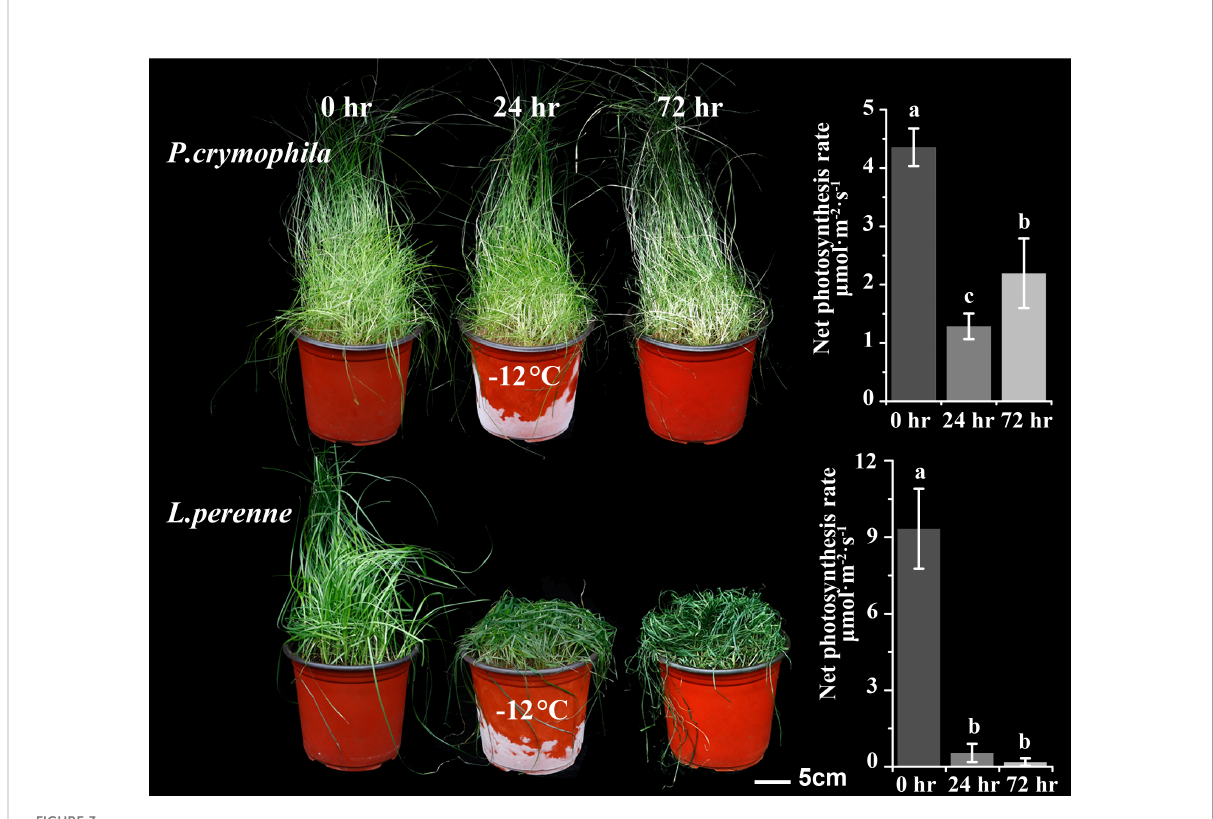
FIGURE 3 The cold stress ( − 12°C) and recovery of P. crymophila and L. perenne